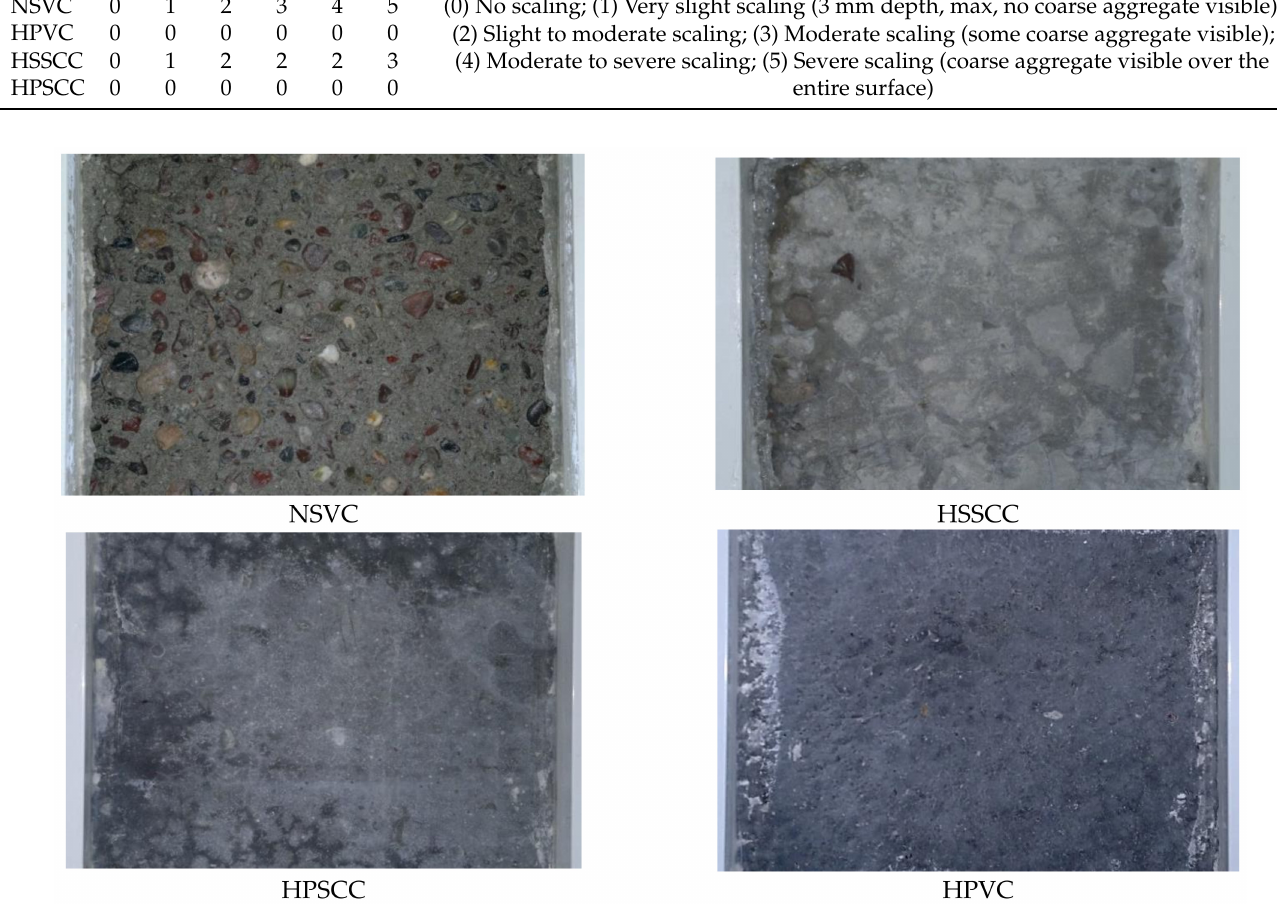
Figure 8. Scaling resistance test of concrete surface exposed to de-icing salts after 50 cycles. When comparing the scaling test results and the results of freezing and thawing test cubes, NSVC had lost 15.8% of its weight in the scaling test, but the loss was 82.6% in concrete cubes. This difference can be justified by the that the cubes were entirely submerged in water and attacked all sides, but the scaling pans were exposed to freeze- thaw cycles only at the top surface. Gagne et al. tested 27 mixes using silica fume with w/b of 0.23, 0.26, and 0.30, and a wide range of air–void systems. All specimens performed exceptionally well in salt scaling, confirming the durability of HPC. Also in [8] the weight loss of 0.1–4.5 kg/m 2 is obtained after 40 cycles of scaling, for 3 concrete types with an air content of 2, 4, and 6% and w/c ratio of